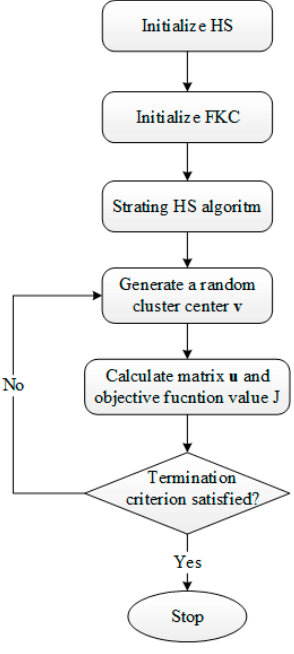
Figure 1. Framework of the proposed method.